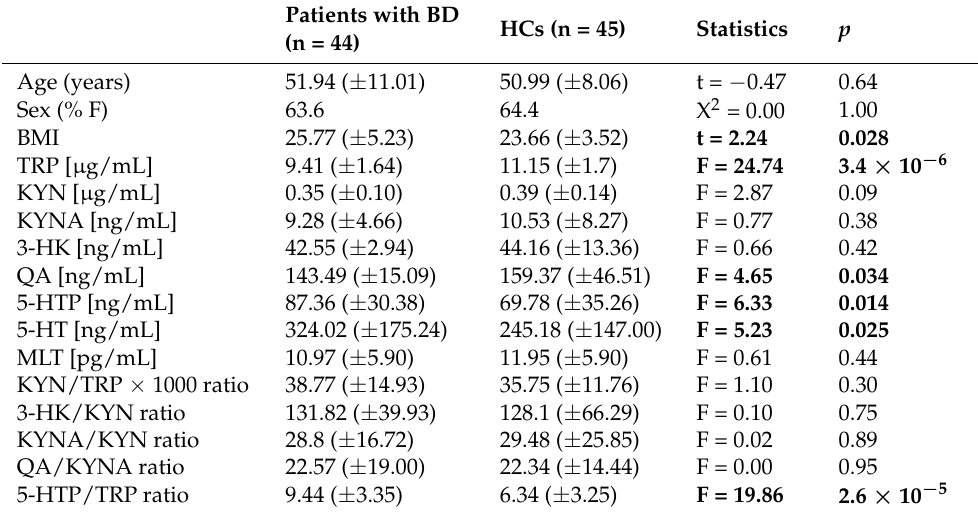
Table 1. Characteristics of the